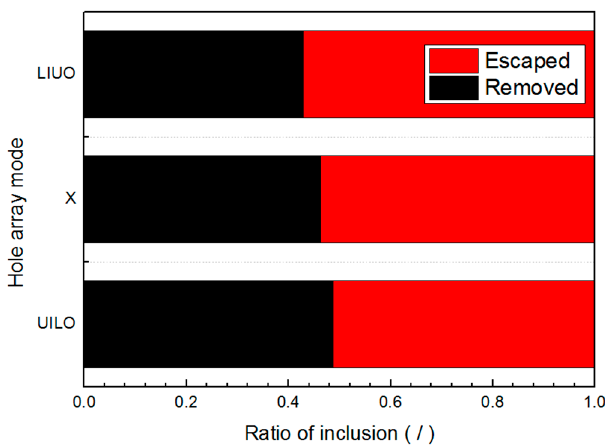
Figure 13. Inclusion removal ratio by the MHDB.